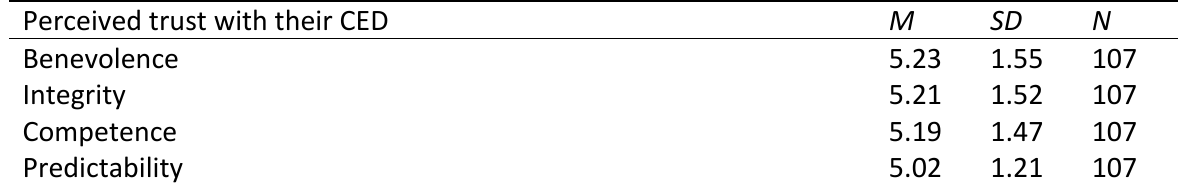
Index Means and Standard Deviations of UF/IFAS Extension Agents’ level of perceived trust with their CED Perceived trust with their CED Benevolence Integrity